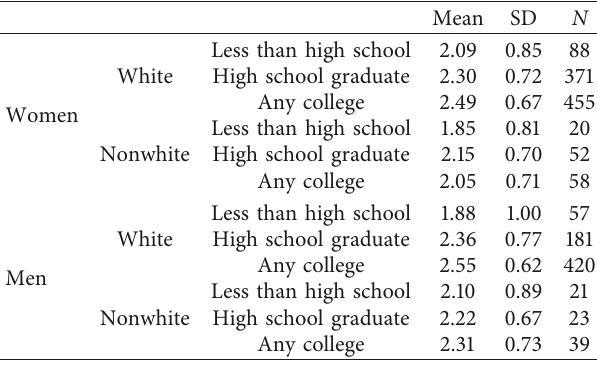
Table 2: Self-rated health by gender, race, and education for